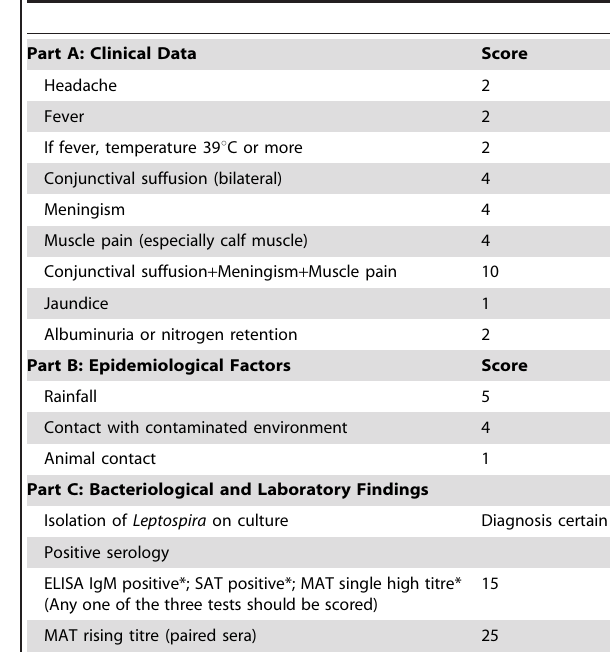
Table 1. Modified Faine’s